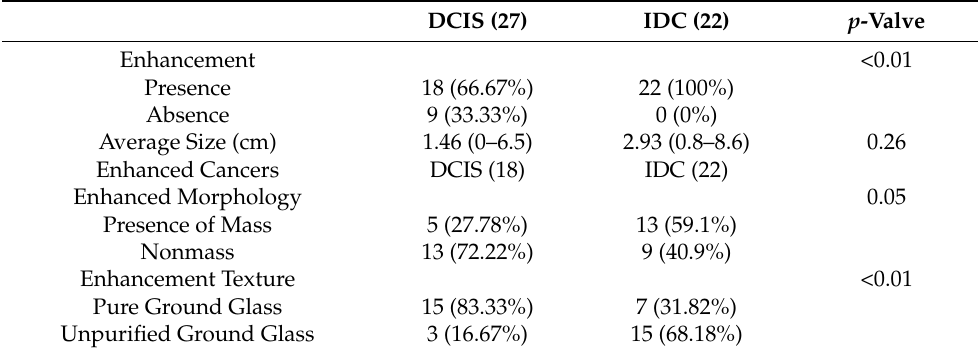
Table 2. Comparison of CESM enhanced features of pure DCIS and